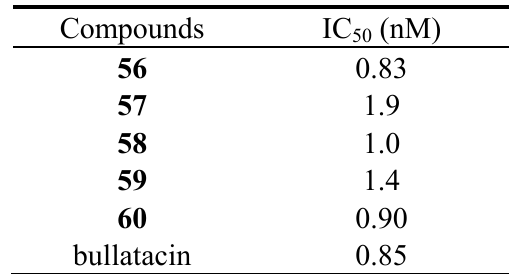
) of the test compounds. 50